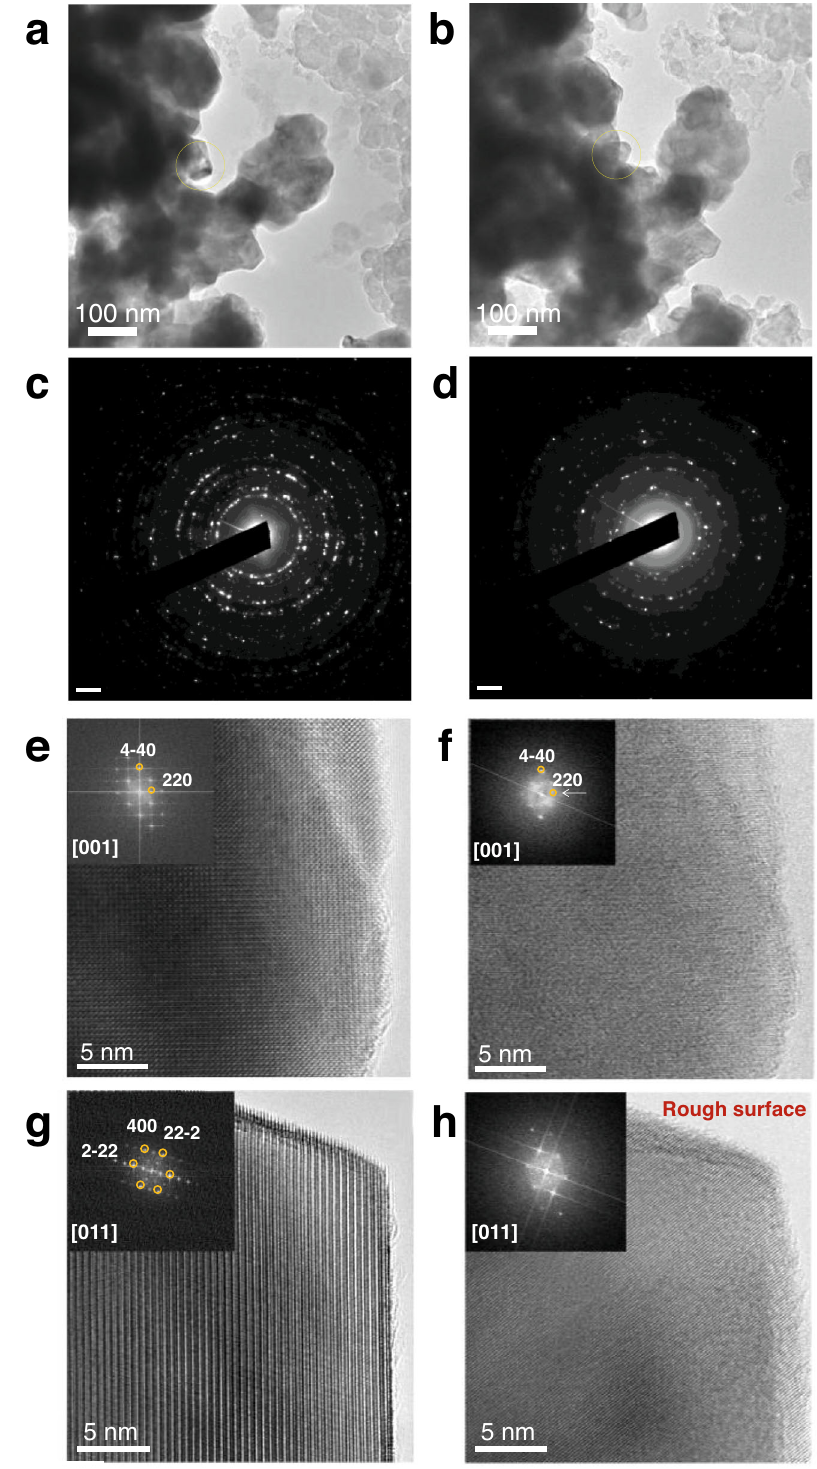
Fig. 4 | Identical locations TEM. Representative TEM images, a before and b after 2000OERcycles.ThecorrespondingSAEDSareshownin c beforeand d after2000 OER cycles.HRTEMimagesof aparticle orientedalong the [011]zone axis e before